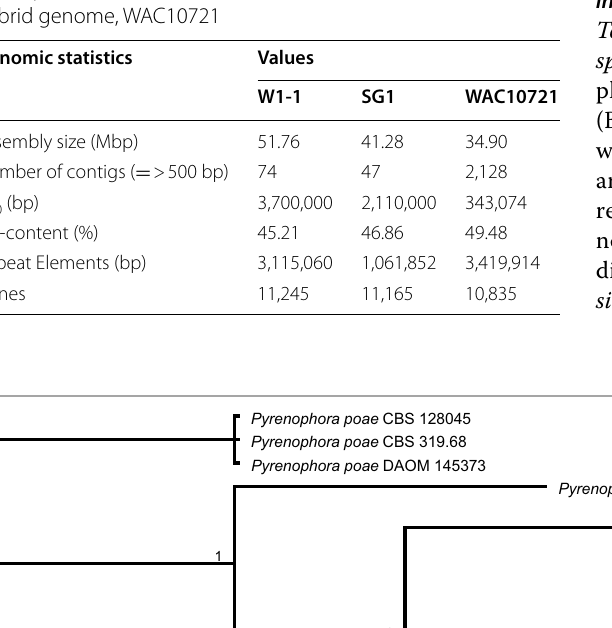
Table 2 Genomic Statistics of the reference genome of